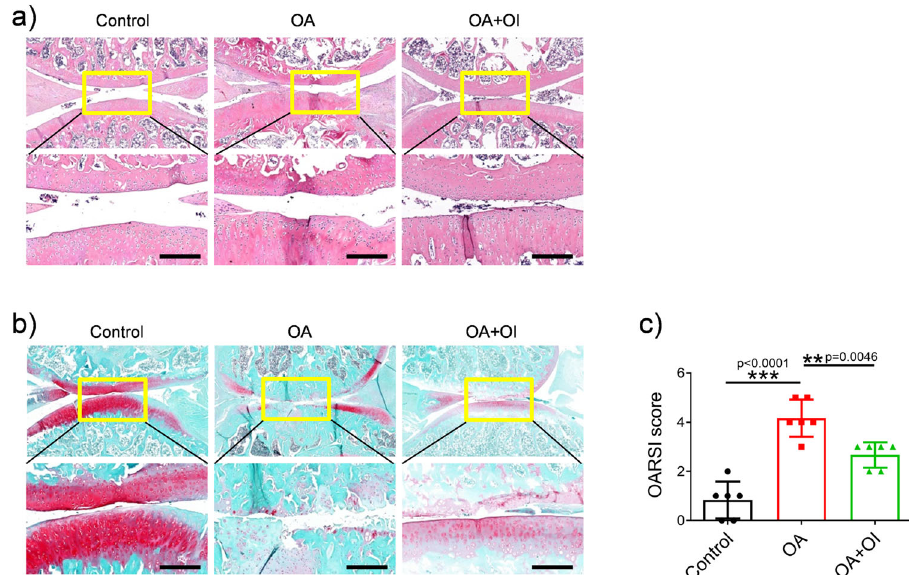
Fig. 8 OI improved osteoarthritis in rats. Histological analysis of knees from Control-, AO- and AO + OI-treated rats. The sections of knee joints were stained with a haematoxylin-eosin staining and b safranin O/fast green staining after 8 weeks of treatment. c OARSI scores were computed using safranin O/fast green stain. Scale bar = 200 μ m. The error bar is SD. The data are the mean ± SD ( n = 6). ** P < 0.01, *** P <